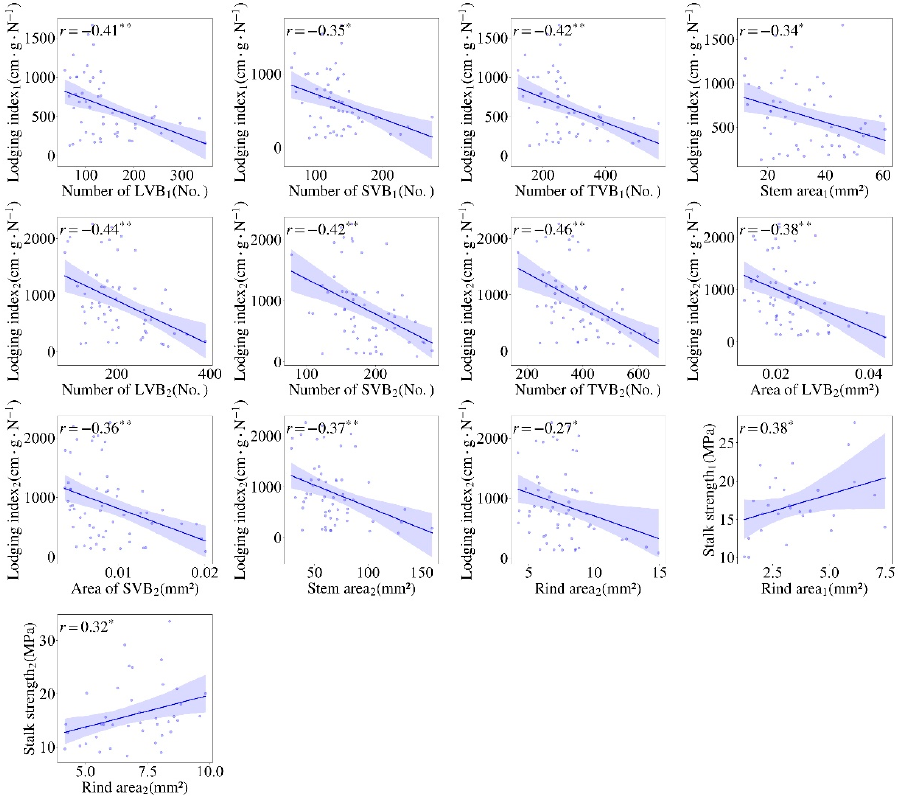
Figure 3. Scatter plots to illustrate the significant correlation between the stem cross-sectional parameters and stalk mechanical properties in sorghum (the subscript numbers “1” and “2” after the traits indicated season 1 and season 2, respectively). * and ** significant at p ≤ 0.05 and ≤ 0.01. Table 4. The variance contributions of sorghum germplasm